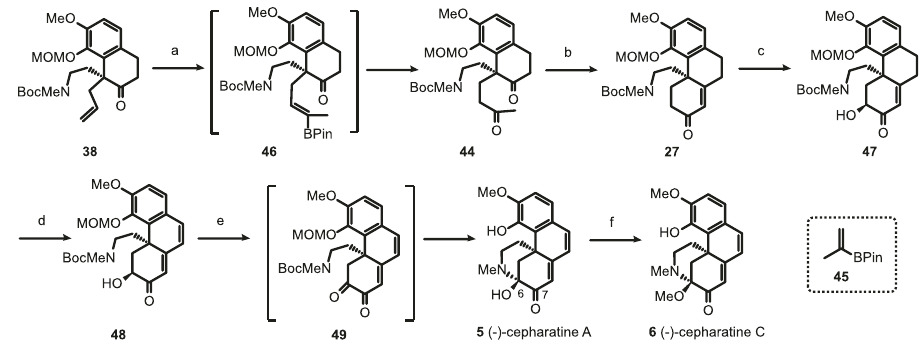
Fig. 5 Total synthesis of (-)-cepharatines A (5) and C (6). Reagents and conditions: (a) isopropenylboronic acid pinacol ester ( 45 , 10.0 equiv), Grubbs second-generation catalyst (0.1 equiv), DCM, 50 °C, then NaBO 3 .4H 2 O (5.0 equiv), THF/H 2 O = 1/1, rt, 62%; (b) 0.5 M NaOMe in MeOH, re fl ux, 70%; (c) LHMDS (2.0 equiv), MoOPH (3.0 equiv), THF, − 78 °C to − 20 °C, 74%; (d) DDQ (10.0 equiv), DCE, 50 °C, 68%; (e) DMP (1.3 equiv), DCM, 0 °C to rt, then TFA, 78%; (f) H 2 SO 4 (1 M in MeOH)/CH(OMe) 3 /MeOH = 0.1/1/1, 65 °C, 95%.